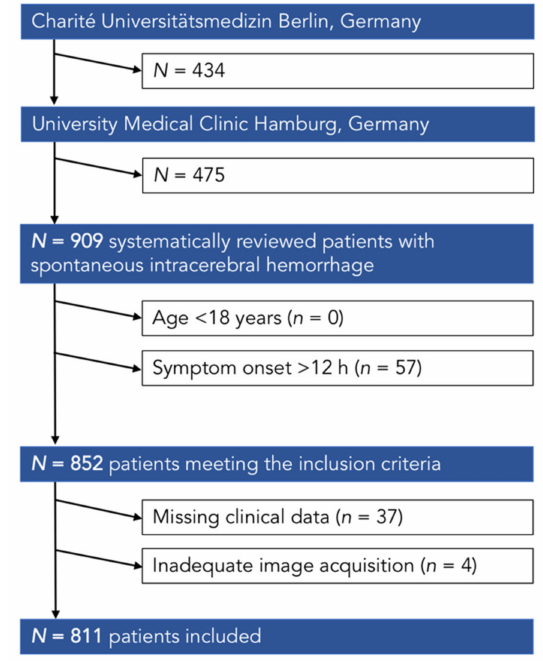
Figure 2. Patient